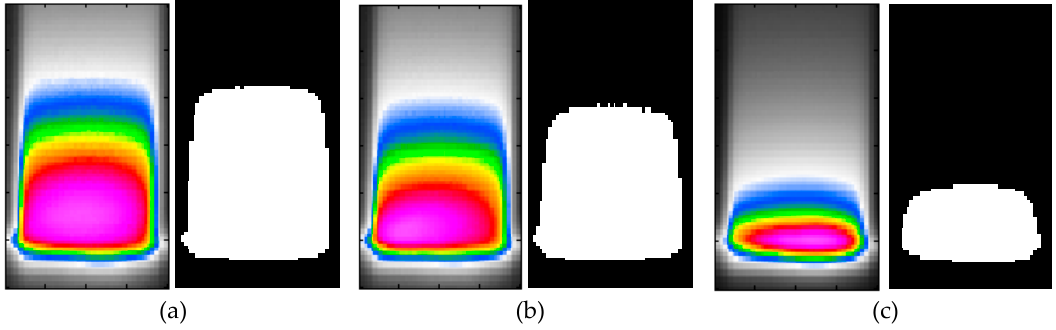
Figure 11. Thermograms of a specimen subjected self-heating, and their corresponding binarized versions: (a) before starting structural degradation, (b) after the initiation of structural degradation, (c) at structural failure.